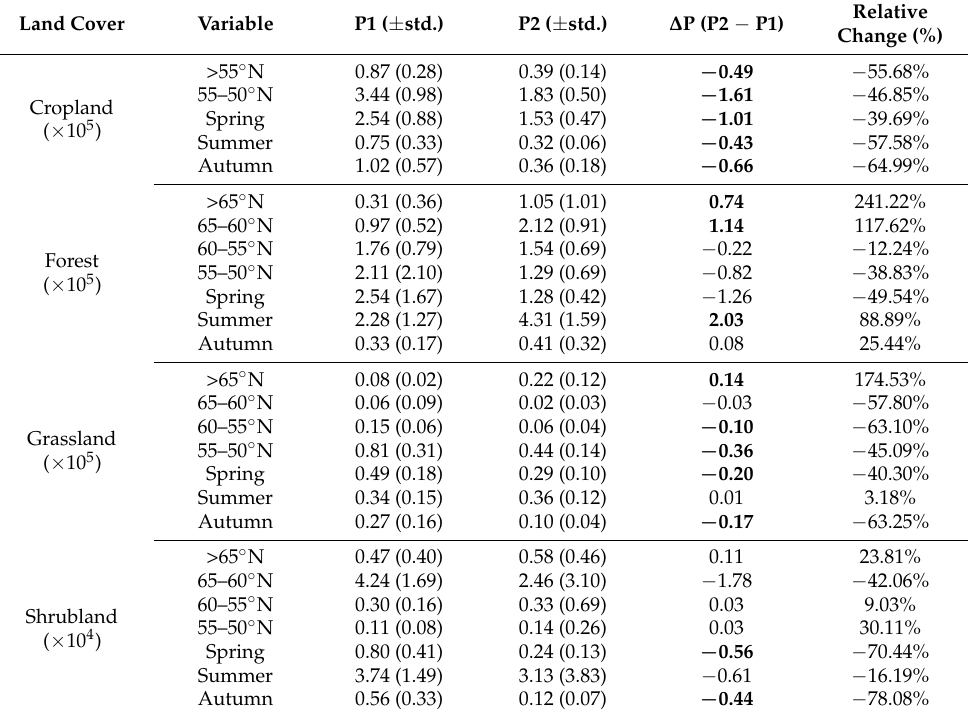
Table 1. Decadal changes of fire counts in different land cover types, latitudinal zones, and seasons during the two